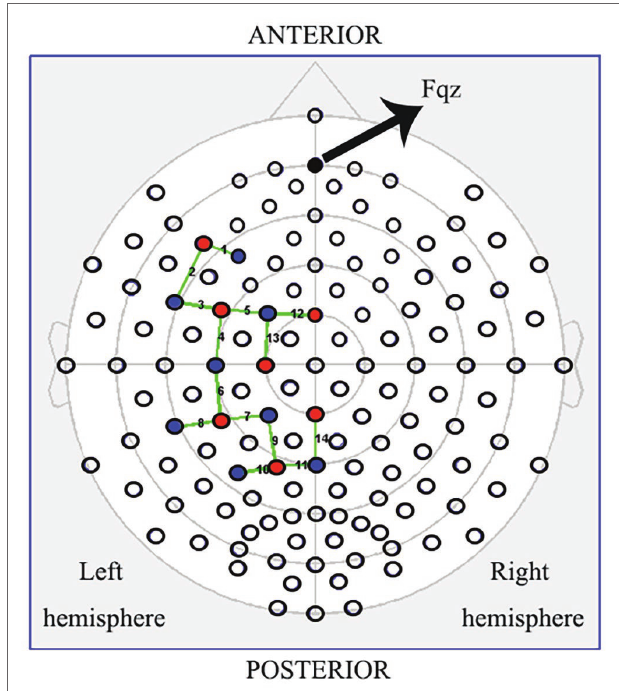
FIGURE 2 | Schematic of the probe setup when positioned on the subject’s head. The NIRSport (NIRx Medical Technologies, LLC, Los) is a continuous- wave fNIRS system consisting of seven light sources (red) and eight detectors (blue) with a 3-cm source-detector separation, comprising 14 channels (green) across the IFG (BA44/45), PMC (BA6), rostral IPL (BA40), and SPL (BA7). Active probes were only in the left